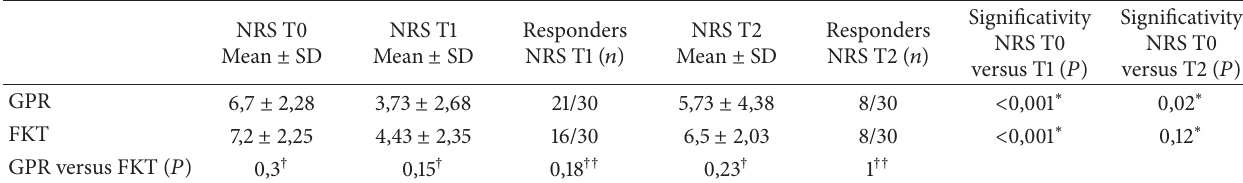
Table 2: Differences in NRS results per group before, after and between